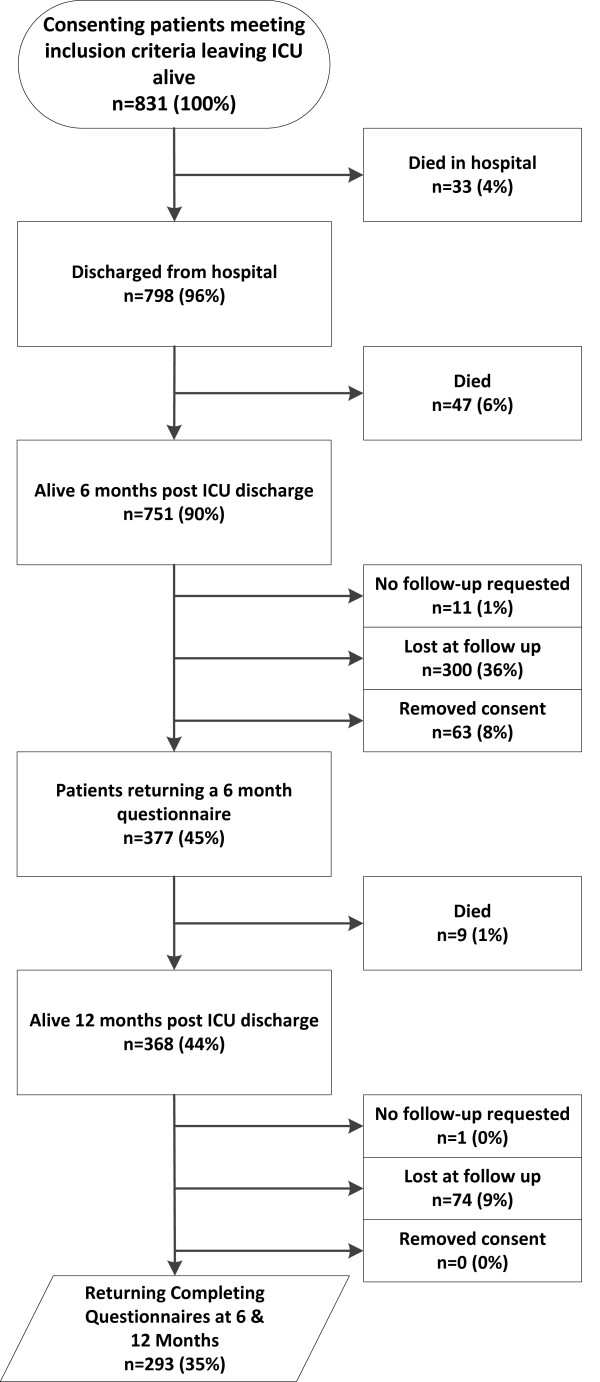
CONSORT diagram.